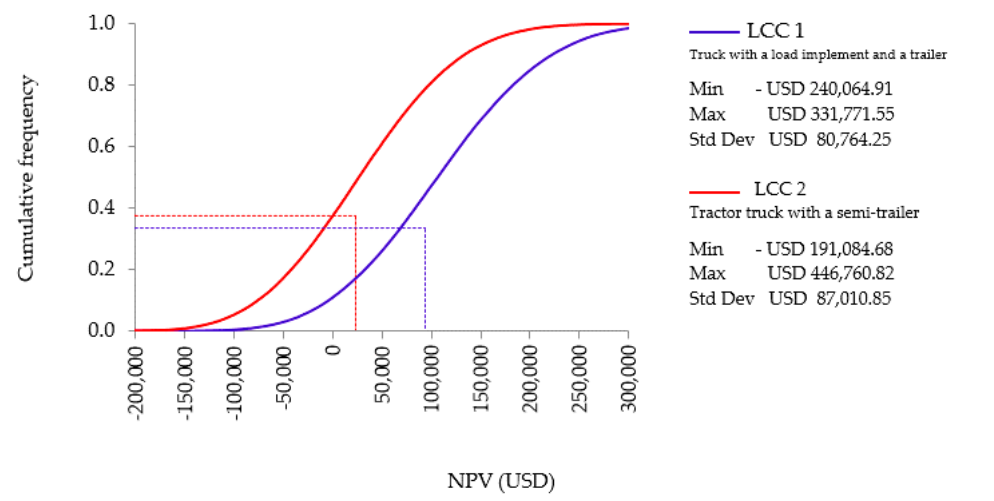
Figure 3. Cumulative frequency of the simulated NPV for the financial investment projects of road transportation of wood.